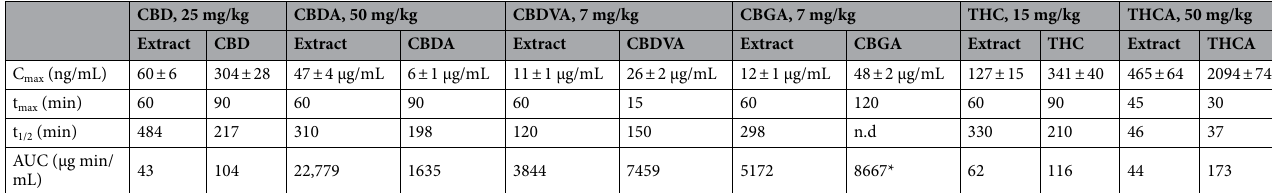
Table 1. Pharmacokinetics of cannabinoids in plasma following oral administration as a full-spectrum extract or individual cannabinoid. n.d. not determined. *AUC does not include terminal